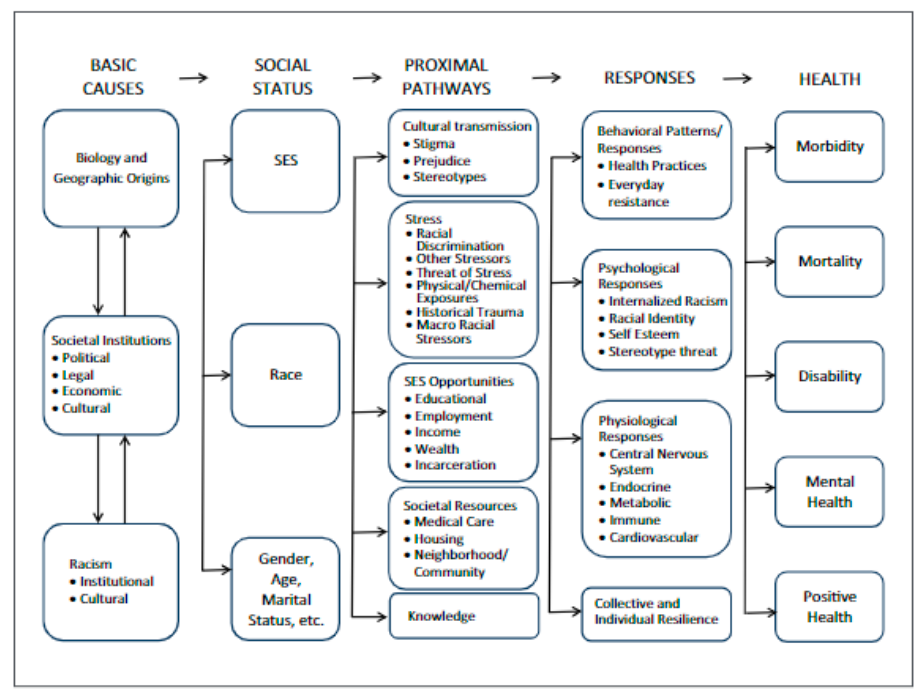
Figure 2. A framework for the study of racism and health (from Williams, 1997 [46]; Williams and Mohammed, 2013 [47]).